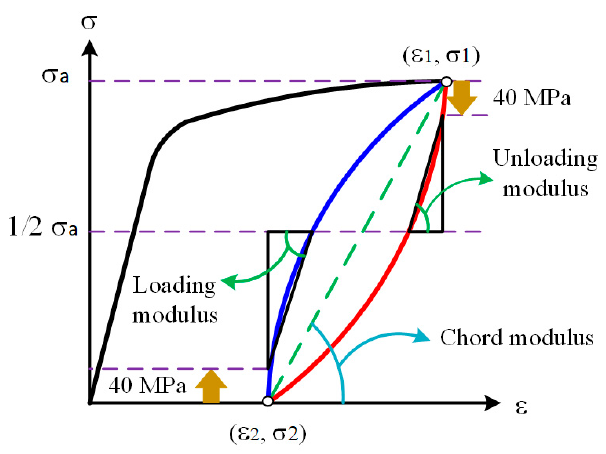
Figure 3. Definition of the elastic modulus.